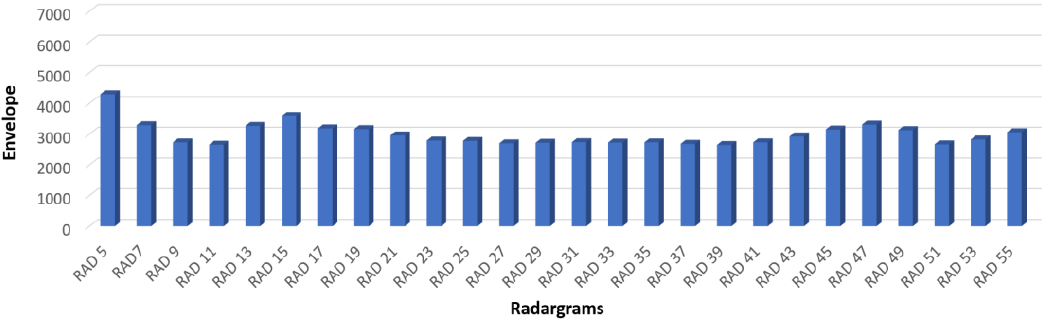
Figure 8. Histogram of the envelope signal at the steel rebar for the radargrams acquired on the concrete sample. The value shows the envelope value on the steel rebar at 0.6 ns time depth.